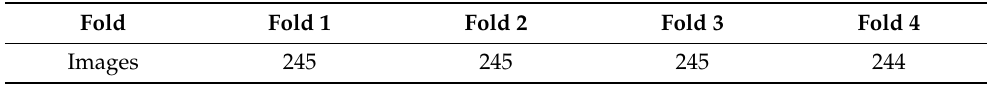
Table 6. Cross Validation Dataset Set Distribution for